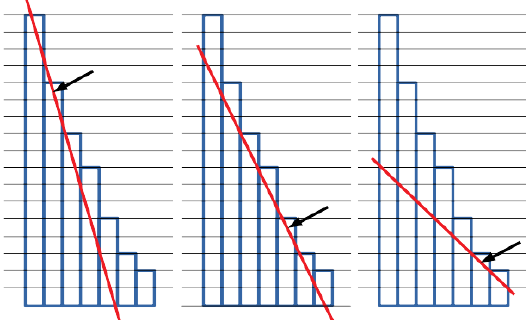
Figure 3. Cutpoint assessment for different